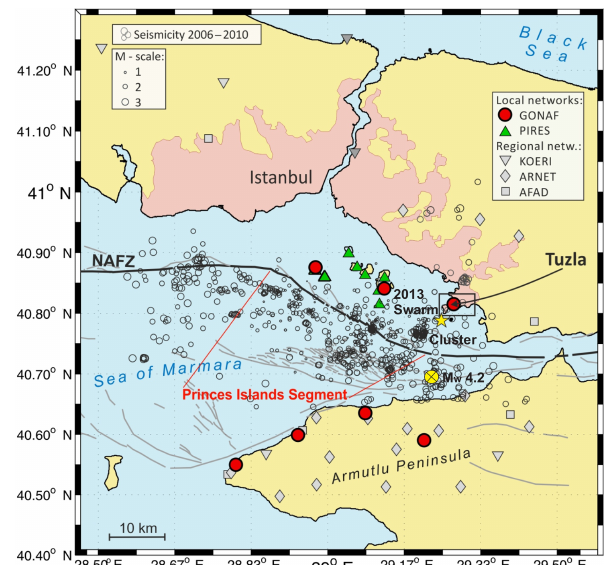
Figure 3. Seismicity map for the eastern Sea of Marmara region for the time period 2006–2010 from surface recordings of the PIRES, AFAD and KOERI stations (Bohnhoff et al., 2013; Prevedel et al., 2015). The yellow star indicates the location of the 2013 microseis- mic swarm recorded by GONAF-Tuzla seismometers (Prevedel et al., 2015; Raub et al., 2016). The yellow circle indicates the location of the Yalova 25 June 2016 M w 4 . 2 earthquake of which waveforms obtained at the GONAF-Tesvikiy (TESV; see Fig. 2 for location) vertical seismic array are shown in Figs.